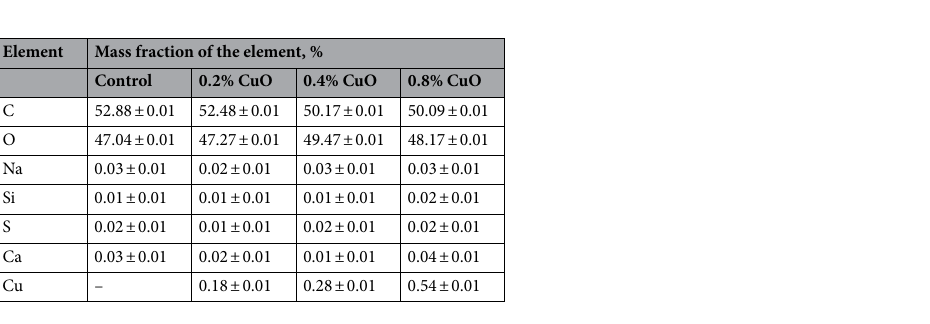
Table 3. Decoding of energy-dispersive spectra of methylcellulose films modified with CuO nanoparticles.